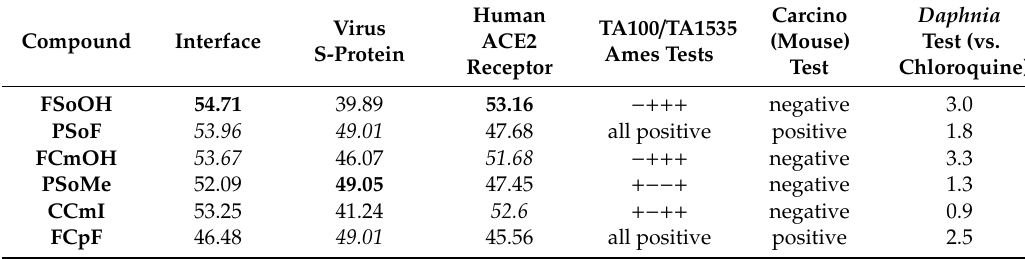
Table 2. ChemPLP docking scores of the studied compounds in relation to S-protein, ACE2 receptor, and their interface and toxicity results for statistical bacteria, mammals, and fish models.